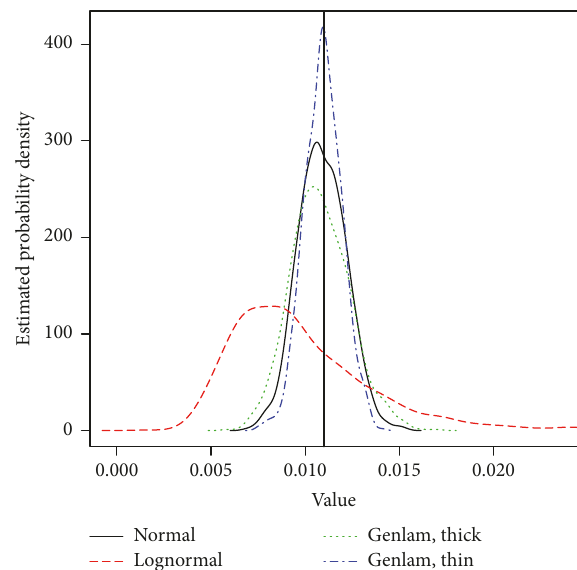
Figure 3: The estimated probability density of Grubbs’ estimator for 𝜎 𝑅𝑂 when the random errors have either a normal, lognormal, or generalized lambda (thin tail or thick tail) distribution. The true value of 𝜎 𝑅𝑂 is 0.0111, indicated by the vertical